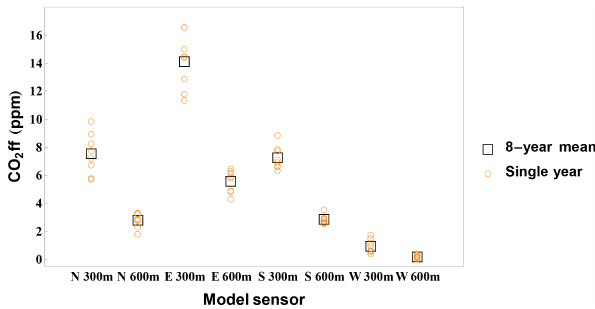
Figure 5. Constant emissions, variable meteorology simulation re- sults for hypothetical sensors: CO 2 ff mole fraction averaged over all eight years of simulation (squares) and individual annual aver- ages (circles). Sensors are labelled on the x axis by direction (N, E, S or W) and distance (300 or 600m) from the source.